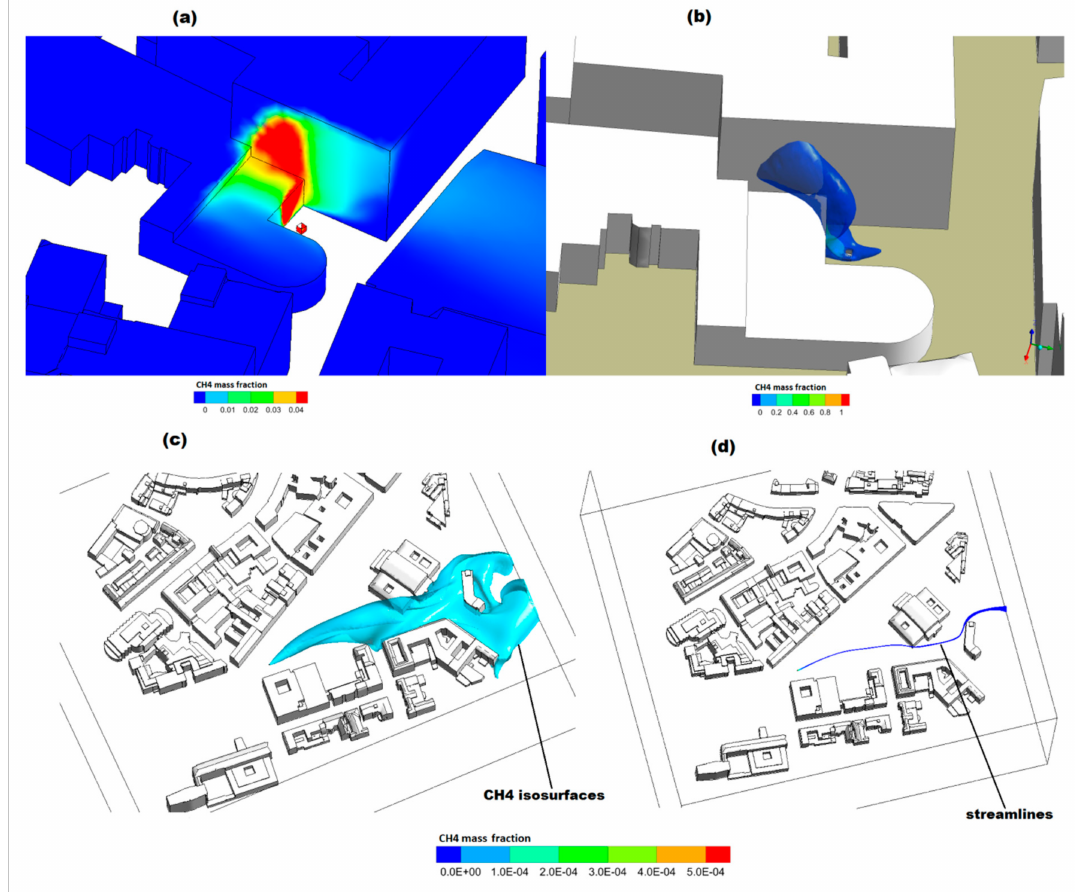
Figure 6. Qualitative results showing the dispersion of methane CH 4 : ( a , b ) From location 1 sited at (x = − 27 m, y = 26 m, z = 1 m) ( c , d ) from location 2 sited at (x = 110 m, y = − 29 m, z = 1